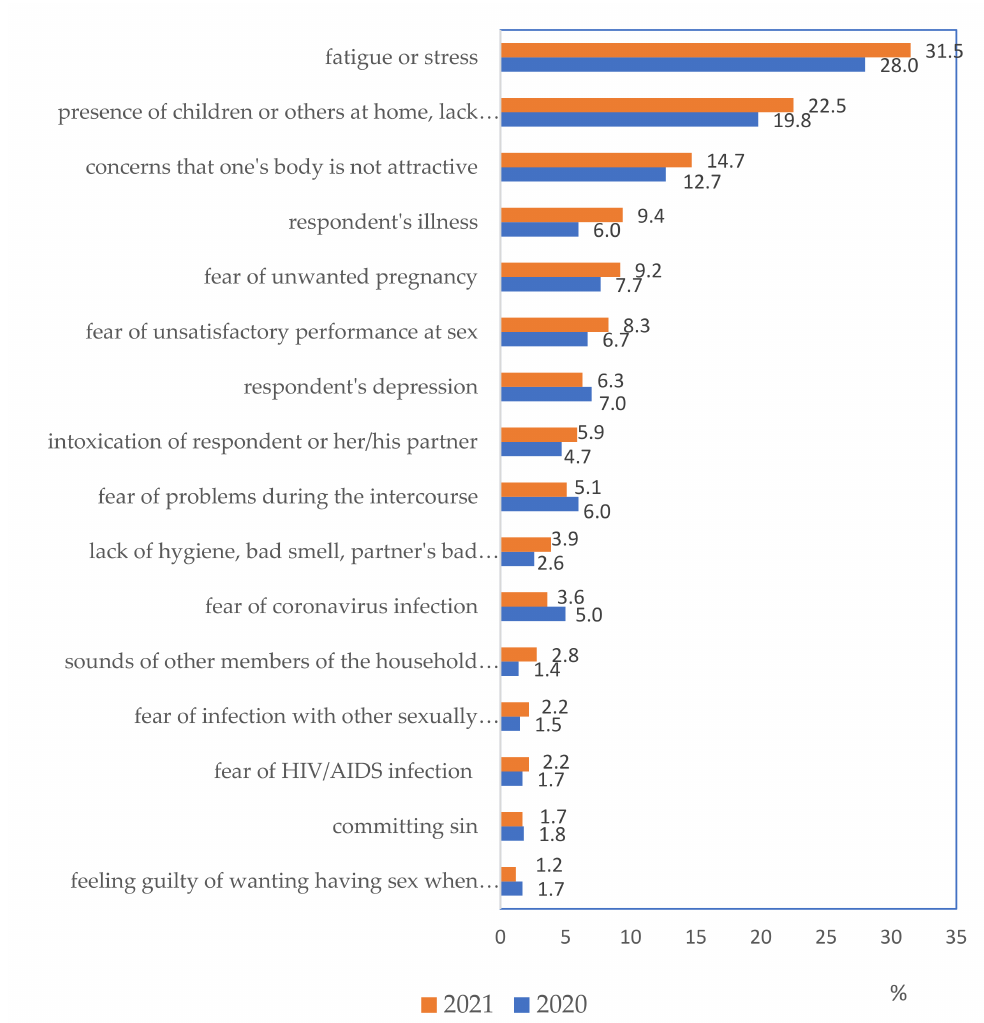
Figure 2. Problems causing difficulties in sexual life during the pandemic (% of those having at least one